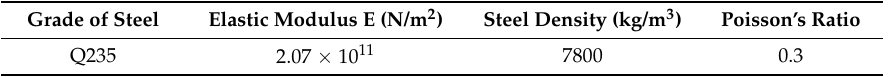
Table 2. The lengths of the bar elements (mm).